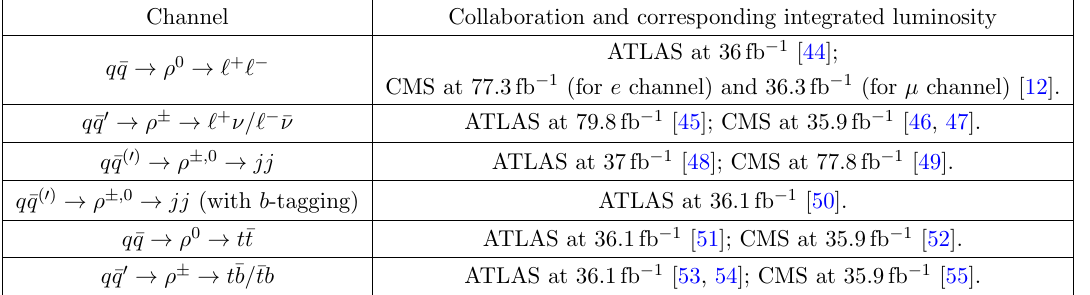
Table 5. The present searches for BSM spin-1 resonances in di-fermion (cid:12)nal states at the 13 TeV LHC. V ! qq